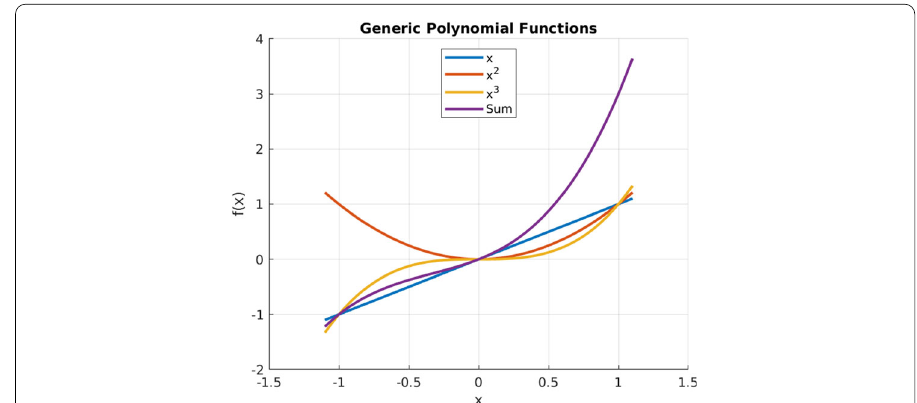
Fig. 1 Scalar function. Plot of generic polynomial function